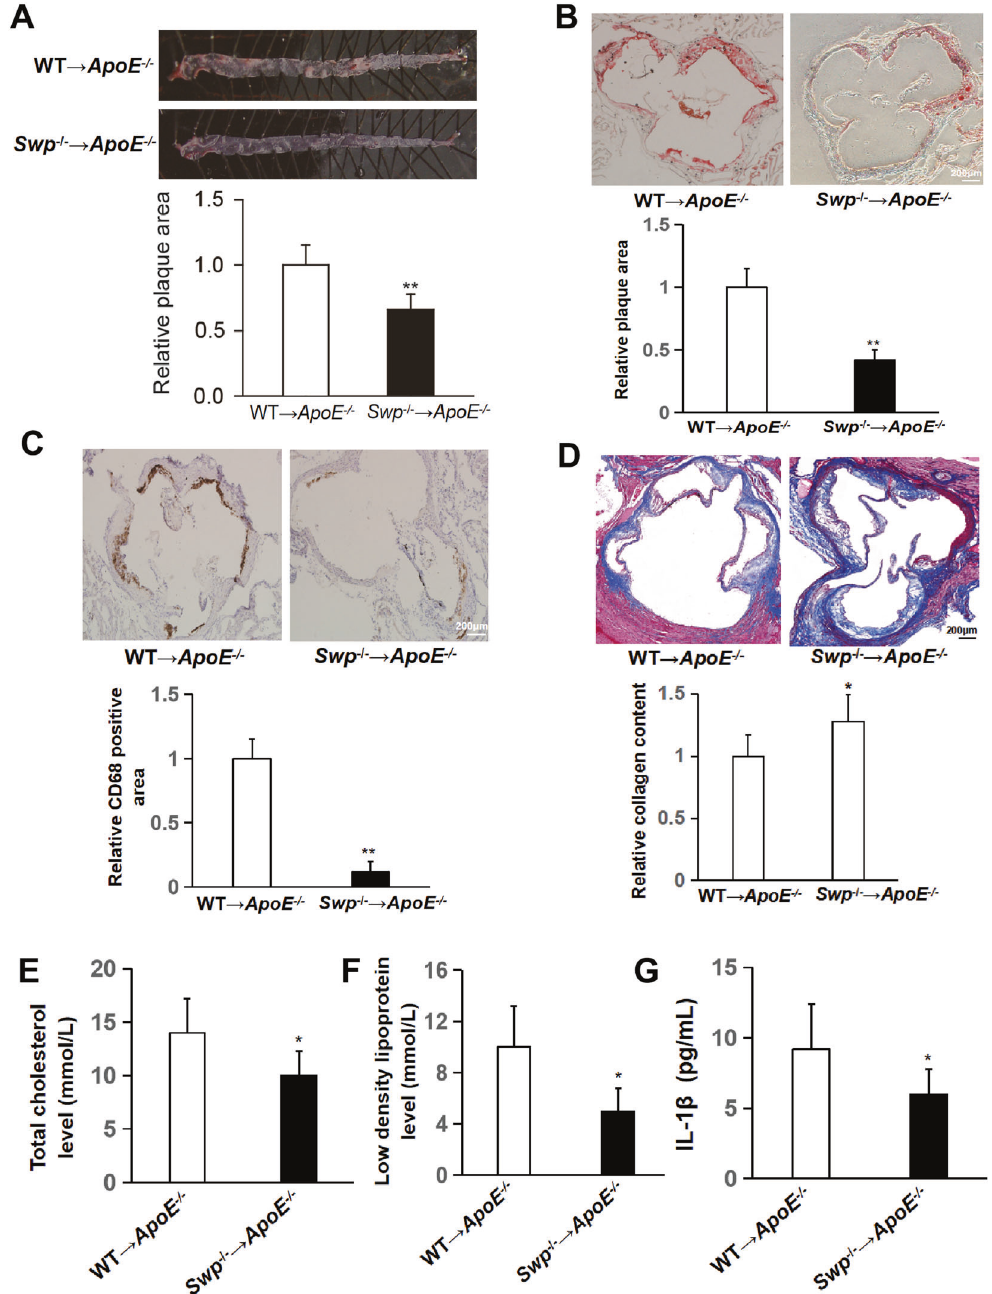
Fig. 3 Swiprosin-1 de fi ciency alleviated atherosclerosis. Atherosclerotic lesion formation was assessed in ApoE − / − mice transplanted with swiprosin-1 − / − ( Swp − / − ) and wild-type mice (WT) bone marrow and fed a high-cholesterol diet for 16 weeks. A Representative images of en face aortas from Swp − / − → ApoE − / − and WT → ApoE − / − mice stained with Oil Red O (upper) and quantitative comparison of atherosclerotic lesion area (down). The plaque-covered area was determined and expressed as a percent of the total area. Data are presented as the mean ± SE; ** P < 0.01, n = 6 per group. B Representative images of aortic root sections stained with Oil Red O (upper) and quantitative comparison of atherosclerotic lesion area (down). Data are presented as the mean ± SE; ** P < 0.01, n = 3 per group. Scale bars are 200 μ m. C Representative images of macrophages in aortic plaque determined by immunohistochemistry using anti-CD68 antibody (upper) and quantitative comparison of CD68-positive area (down). Data are presented as the mean ± SE; ** P < 0.01, n = 3 per group. Scale bars are 200 μ m. D Representative images of collagen content assessed by Masson ’ s trichrome stain (upper) and quantitative comparison of collagen content (down). Data are presented as the mean ± SE; * P < 0.05, n = 3/group. Scale bars are 200 μ m. Serum total cholesterol ( E ), low-density lipoprotein ( F ), and IL-1 β ( G ) were determined by ELISA kit. Data are presented as the mean ± SE; * P < 0.05, n = 6 – 7/group. between swiprosin-1 KO macrophages and control macro- of LDL by macrophages was enhanced after swiprosin-1 KO phages induced by ox-LDL. Thus, we wondered whether the (Fig. 4C). The mRNA expression of SR-A was enhanced in cellular cholesterol ef fl ux might be increased in swiprosin-1 KO swiprosin-1 KO macrophages compared to the control macro- macrophage. phages. The expression of CD36 mRNA was no different Cell Death Discovery (2021)